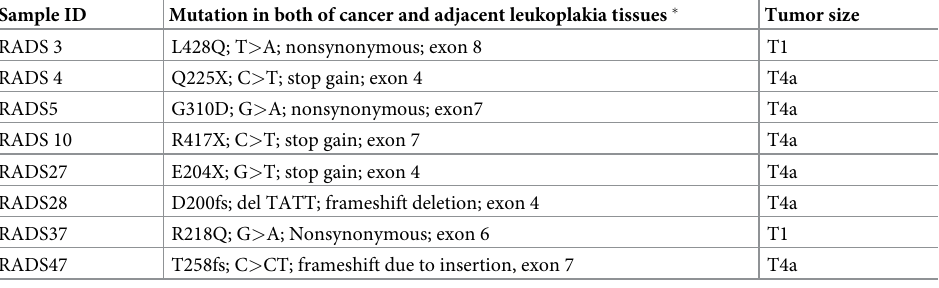
Table 2. Presence of mutation in CASP8 in both of cancer and adjacent leukoplakia tissues from same patient (n =